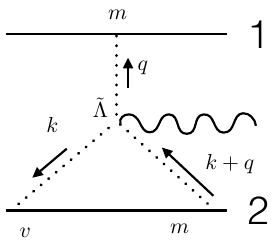
Figure 7 . A diagram with the (cid:12)rst \topology" for the leading order radiative correction diagram 2 for ~ C